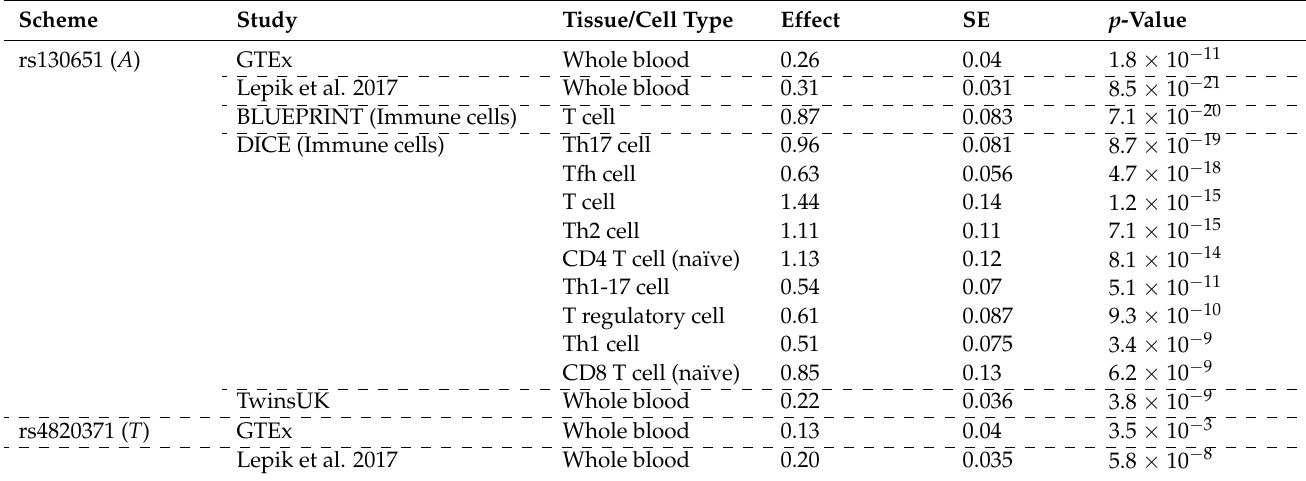
Table 2. Summary statistics of eQTL associations between the two SNPs (rs130651 and rs4820371) and the PDGFB gene expression levels from different tissue and cell types in the GTEx and FIVEx databases.